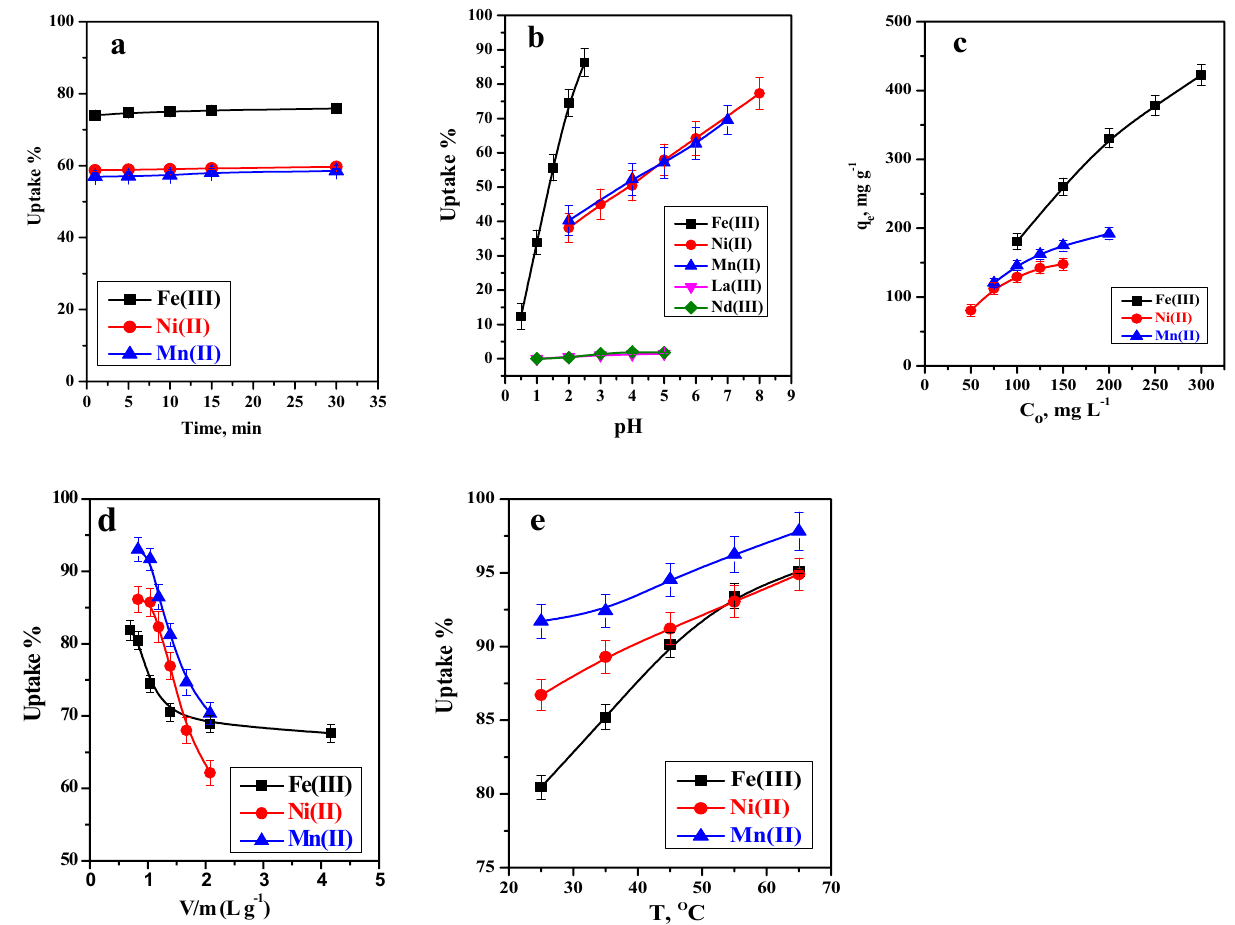
Figure 4. Effect of ( a ) contact time on uptake percent of Fe 3+ ([Fe] = 100 mg/L, pH = 2), Ni 2+ ([Ni] = 50 mg/L, pH = 5) and Mn 2+ ([Mn] = 100 mg/L, pH = 5) from aqueous media, V/m = 2.1 L/g, T = 25 °C, ( b ) Effect of aqueous solution pH on uptake percent of 100 mg/L Fe 3+ , 50 mg/L Ni 2+ , 100 mg/L Mn 2+ , 100 mg/L La 3+ and 100 mg/L Nd 3+ from aqueous media, V/m = 2.1 L/g, T = 25 °C after 1.0 min, ( c ) Relation between the adsorbed amount, q e , of Fe (pH = 2.5), Mn (pH = 7.0) and Ni (pH = 8.0) and the initial concentrations of these ions, V/m = 2.1 L/g, T = 25 °C after 1.0 min, ( d ) effect of V/m ratio on uptake percent of Fe 3+ ([Fe] = 300 mg/L, pH = 2.5), Ni 2+ ([Ni] = 100 mg/L, pH = 8) and Mn 2+ ([Mn] = 100 mg/L, pH = 7) from aqueous media, T = 25 °C after 1.0 min, ( e ) effect of temperature on uptake percent of Fe 3+ ([Fe] = 300 mg/L, pH = 2.5, V/m = 0.83 L/g), Ni 2+ ([Ni] = 100 mg/L, pH = 8, V/m = 1.04 L/g) and Mn 2+ ([Mn] = 100 mg/L, pH = 7, V/m = 1.04 L/g) from aqueous media, after 1.0